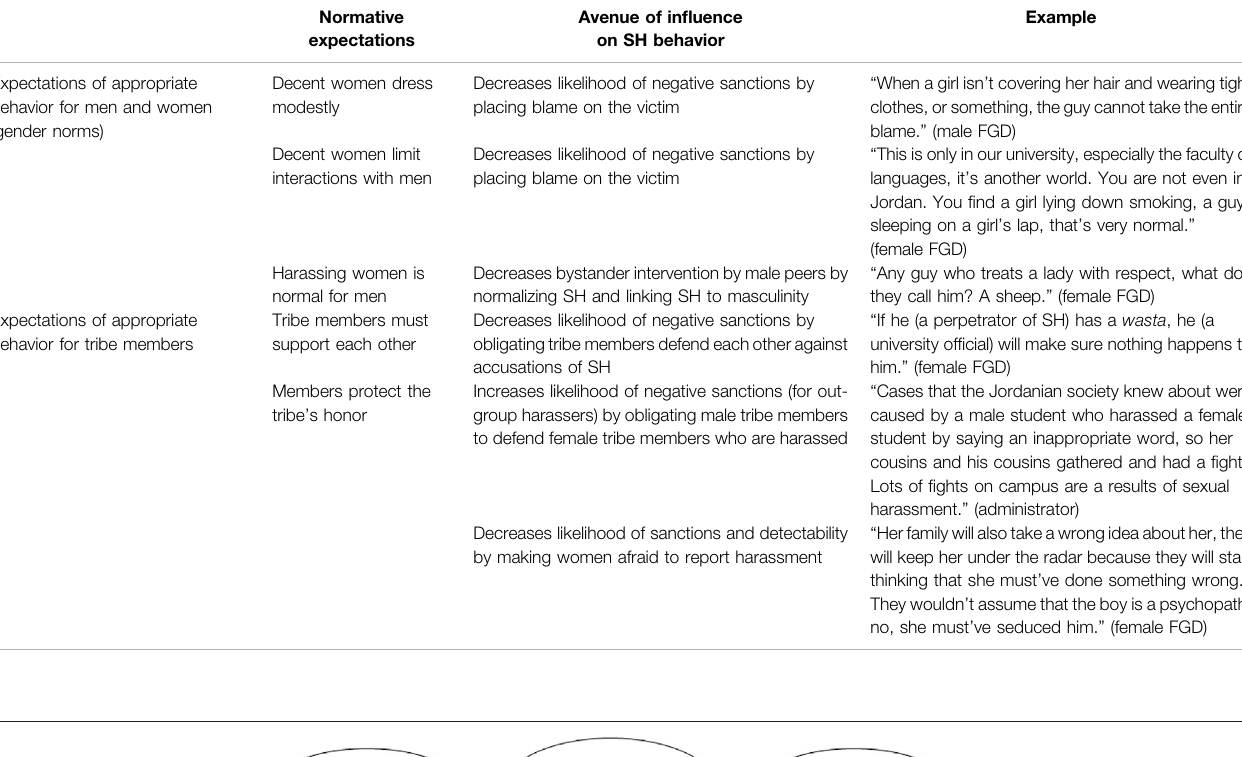
TABLE 2 | Distal norms in fl uencing SH and their perceived impact on SH behavior.